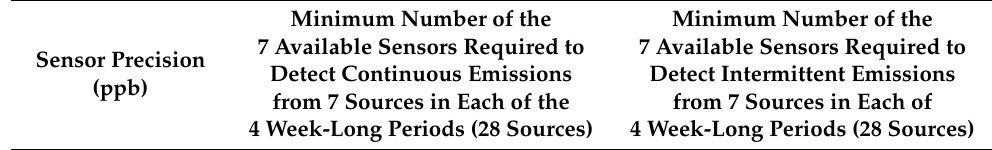
Table 2. Sensors required to detect emissions from each of the 7 emissions sites, in each of the 4 weeks of meteorology evaluated in this work (28 total detections). Minimum Number of the Minimum Number of the 7 Available Sensors Required to 7 Available Sensors Required to Sensor Precision Detect Intermittent Emissions Detect Continuous Emissions (ppb) from 7 Sources in Each of from 7 Sources in Each of the 4 Week-Long Periods (28 Sources) 4 Week-Long Periods (28 Sources) Emission rate of 10 kg/h 1000 7 7 sensors made 25 detections *